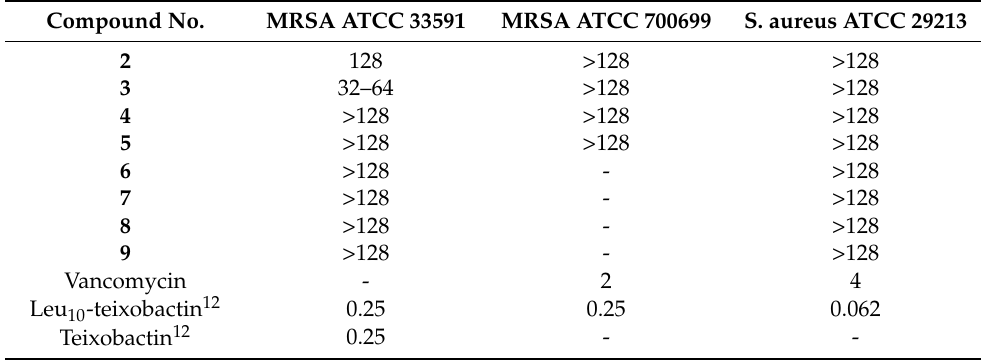
Table 1. List of teixobactin analogues ( 2 – 9 ). MIC: Minimum Inhibitory Concentration in µ g/mL; all the MIC runs in triplicate. (-) = Not